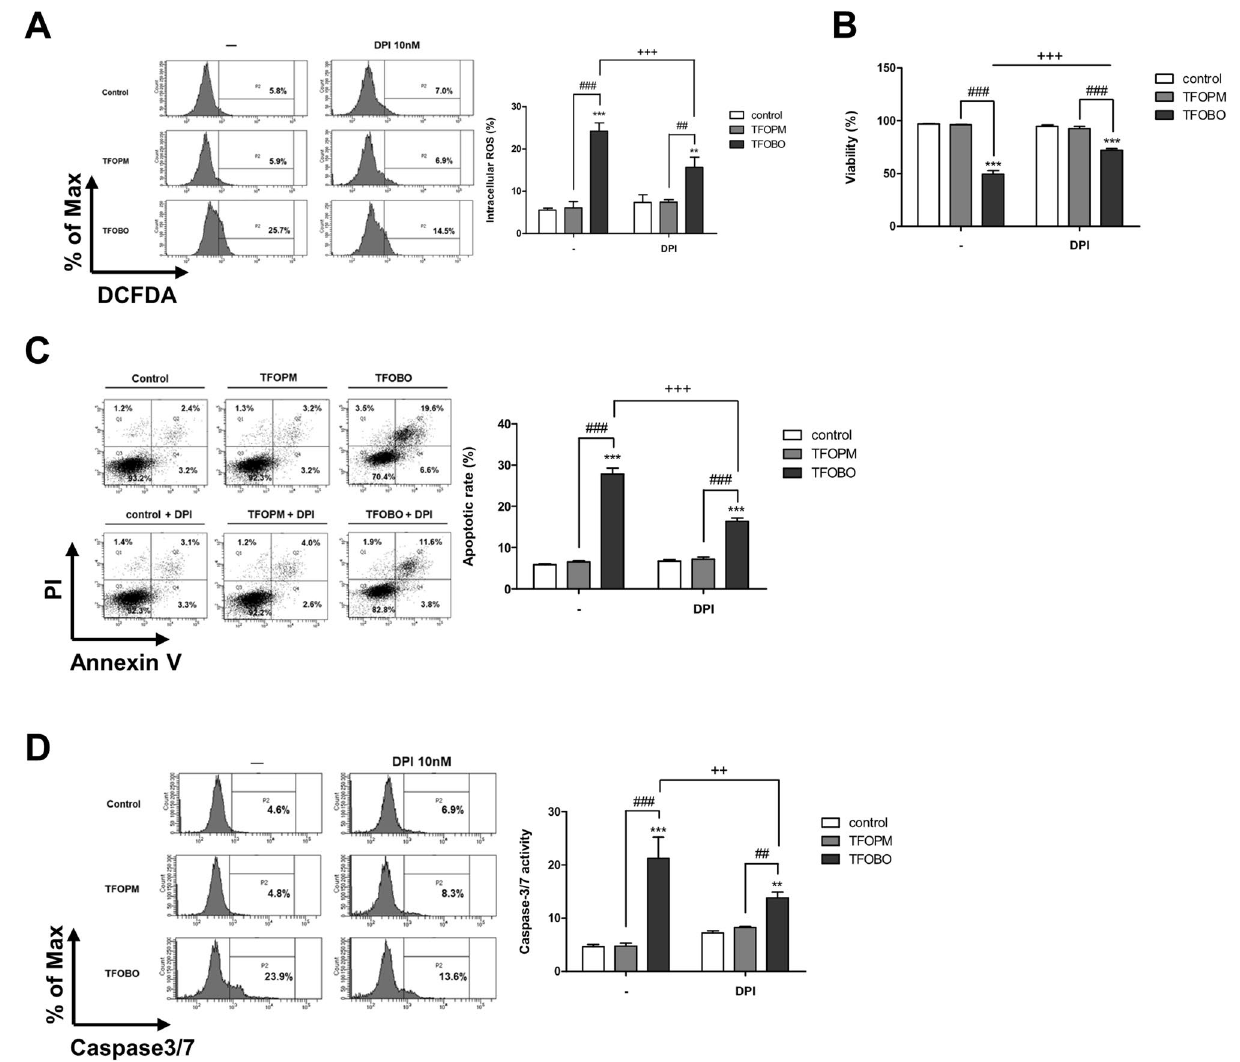
Figure 3. DPI treatment rescues ((2,4,5-trifluorobenzyl)oxy)-benzene derivative (TFOBO)-mediated cell death in myeloid leukemic cells. ( A) Serum-starved THP1 cells are incubated with 2 ′ ,7 ′ -dichlorofluorescein diacetate for 30 min and pre-incubated in 10 nM DPI for 30 min prior to treatment of TFOBO. The ROS generation is measured by flow cytometric analysis, and the representative data from three independent experiments are shown. **p < 0.01 ***p < 0.001 vs. control; ## p < 0.01, ### p < 0.001 vs. (2-((2,4,5-trifluorobenzyl)oxy)phenyl) methanol [TFOPM]; +++ p < 0.001 vs. TFOBO alone. ( B ) After serum-starvation, THP1 cells are pre-treated with 10 nM DPI for 30 min, followed by treatment with TFOBO at 4 µg/ml for 48 h. The viability is measured using a Vi-cell counter. ( C ) Analysis of apoptosis using annexin V and ( D ) caspase3/7 activity is subjected to flow cytometric analysis. **p < 0.01, ***p < 0.001 vs. control; ## p < 0.01, ### p < 0.001 vs. TFOPM; ++ p < 0.01, +++ p < 0.001 vs. TFOBO alone. The graphs are presented as mean ± SD (n = 3 replicates for each group). Representative data from three independent experiments are molecules in the chemoprevention and chemotherapy treatment of myeloid leukemia. Thus, further investiga- tions are needed to confirm its potential usefulness as a chemotherapeutic agent.